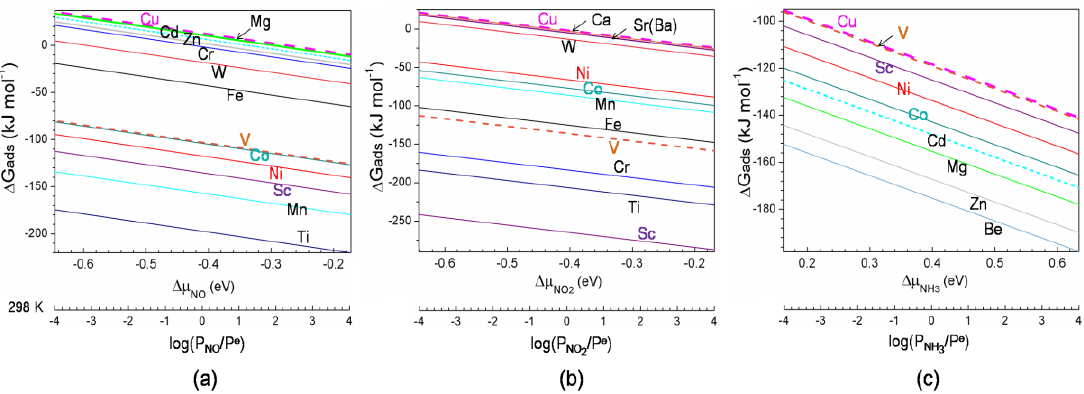
Figure 3. Adsorption Gibbs free energy, ∆ G ads (T, P) of ( a ) NO, ( b ) NO 2 , and ( c ) NH 3 adsorption on various M-HKUST-1 as a function of the nitrogen-containing compound (NCC) chemical potential, where µ NCCs is defined as G θ (T) + RTln(P NCCs /P θ ) including zero-point vibrational energy. The corresponding pressure is provided for the selected temperature. To make the picture clear, only those with larger ∆ G ads (T, P) than Cu-HKUSU-1 are included in the figure.